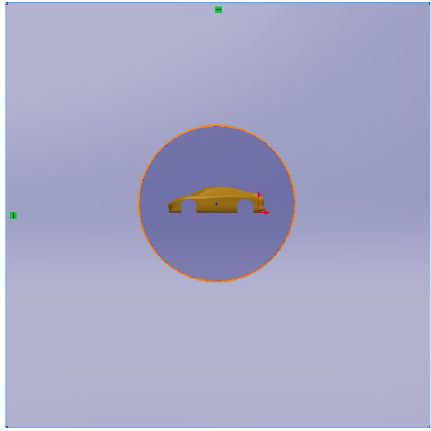
Figure 7. Distributions of boundary source points and test points.